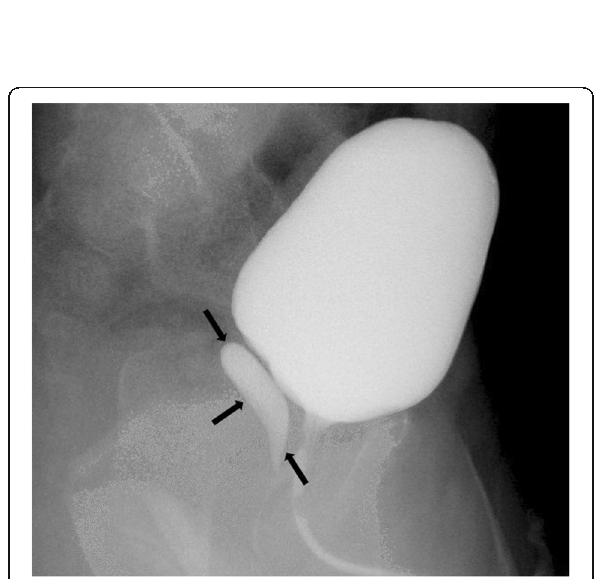
Fig. 36 A 5-year-old male patient with recurrent urinary tract infection. Voiding cystourethrogram demonstrates a contrast filling prostatic utricle cyst (arrows)